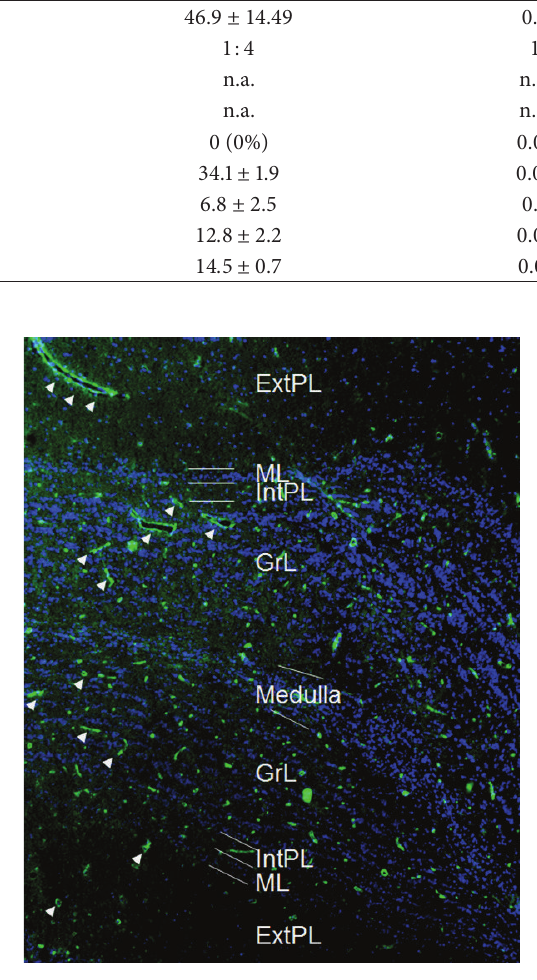
Figure2:BindingofserumNMO-IgGtotheinnerportionoftherat olfactory bulb as demonstrated by indirect immunohistochemistry. See results section for details. Binding of the patient’s IgG is shown in green (AF488); cell nuclei are shown in blue (4 󸀠 ,6-diamidino- 2-phenylindole). Arrowheads = microvasculature; ExtPL-external plexiform layer; ML-mitral cell layer; IntPL = internal plexiform layer; GrL = granular